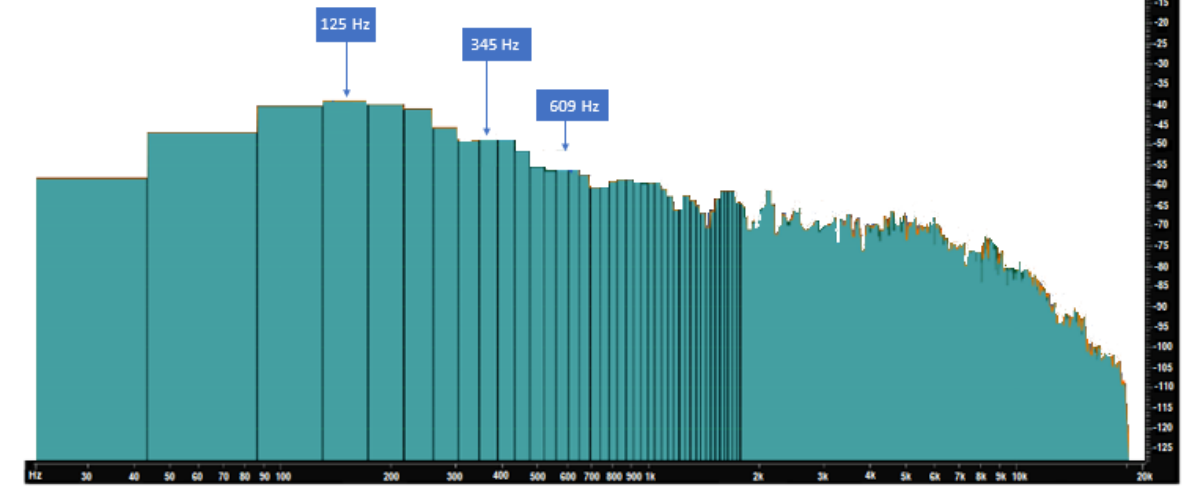
Figure 5. Frequency spectrum of the synthesized sample mixed with the noise generated by the transformers.